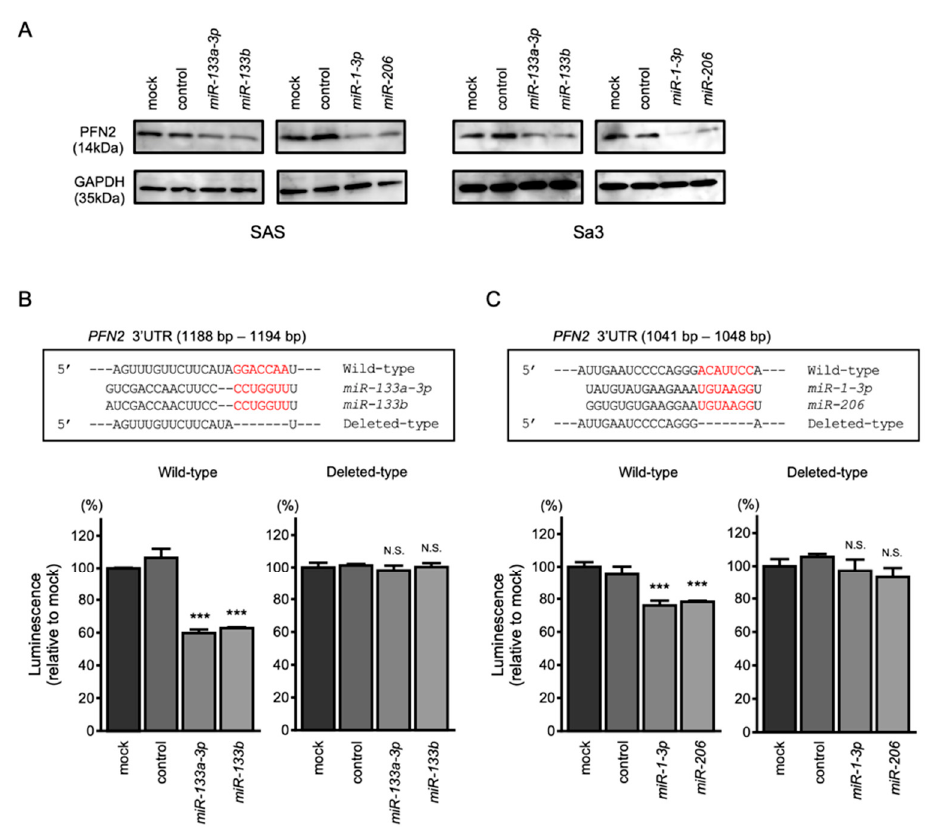
Figure 6. Direct regulation of PFN2 by miR-1 / miR-133 clustered miRNAs in HNSCC cells. ( A ) Western blot of PFN2 protein 48 h after miR-133a-3p / miR-133b and miR-1-3p / miR-206 transfection of SAS and Sa3 cells. ( B ) The TargetScan database shows that a single putative miR-133a-3p / miR-133b binding site predicts the 3 (cid:48) -UTR of the PFN2 sequence (upper panel). Dual-luciferase reporter assays after co-transfection of the wild-type or deleted-type vector and miR-133a-3p / miR-133b in Sa3 cells (lower panel). ( C ) The TargetScan database shows that a single putative miR-1-3p / miR-206 binding site predicts the 3 (cid:48) -UTR in the PFN2 sequence (upper panel). Dual-luciferase reporter assays after co-transfection of the wild-type vector or deleted-type vector and miR-133a-3p / miR-133b in Sa3 cells (lower panel). (*** p < 0.001, N.S.: not